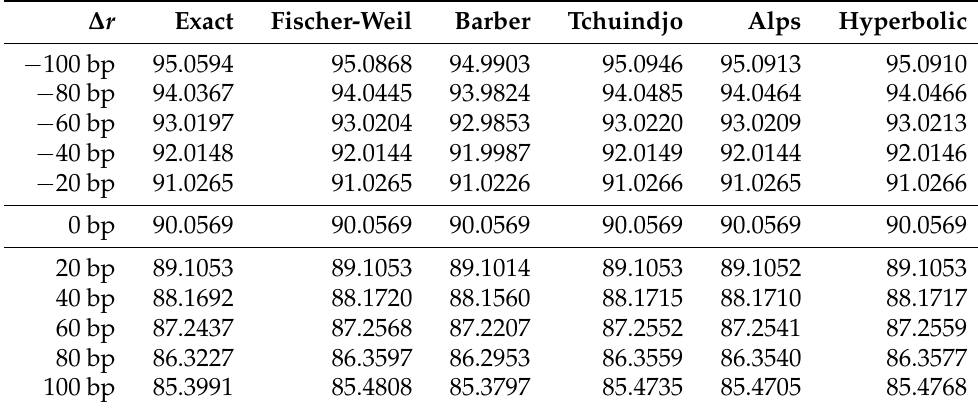
Table 5. NPV of 10-year par bond with coupon rate r 0 , callable for 101 at t =